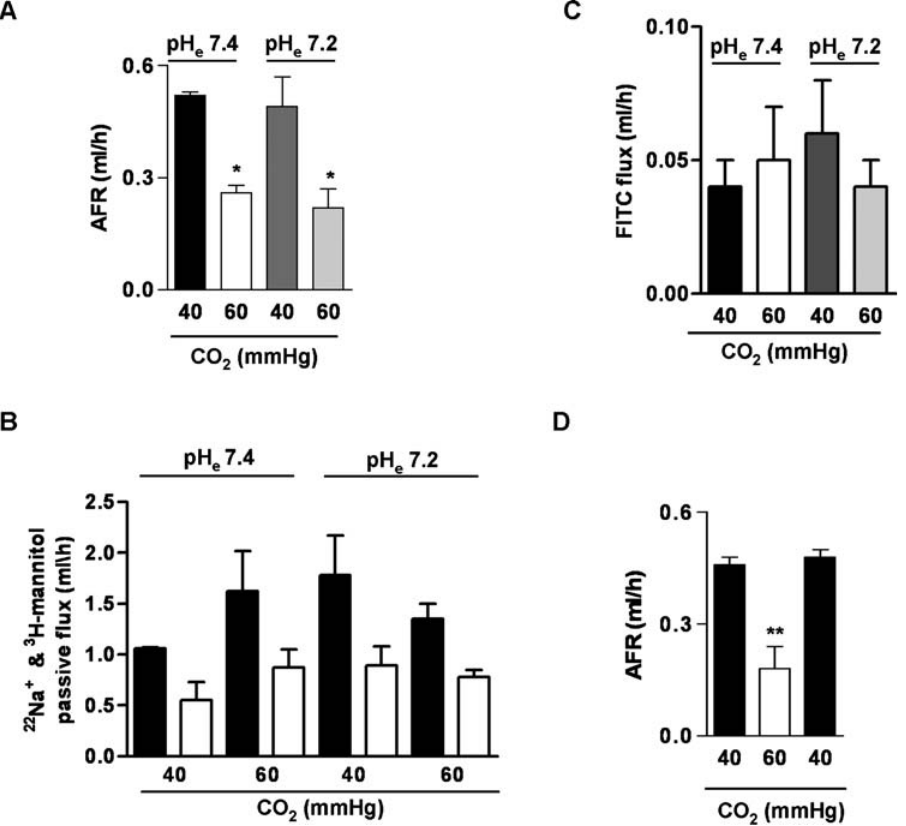
Figure 1.HighCO 2 levelsimpairalveolar epithelialfunction inrats . (A) Isolatedrat lungs wereperfused for 1 hwith40or60 mmHg CO 2 withpH e : 7.4 or pH e : 7.2 and alveolar fluid reabsorbtion (AFR) was measured as described in the experimental procedures. Graph represents the mean 6 SEM, (n=5). (B) Passive movement ofNa + (closed bars) and 3 H-Mannitol (open bars)was measured asdescribedindetail in the supplementarymethods. Graphrepresents the mean 6 SEM(n=5). Differencesamong groupswerenotstatistically significant. (C) Albuminflux fromthe pulmonary circulationintothe alveolarspace was determined from the fraction of fluorescein isothiocyanate (FITC)-labeled albumin, placed in the perfusate that appeared in the alveolar instillate during the experimental protocol. Graph represents the mean 6 SEM, (n=5). Differences among groups were not statistically significant. (D) A three hour experiment was performed in isolated rat lungs. Lungs were perfused for 1h with 40 mmHg CO 2 , switched to 60 mmHg CO 2 for the second hour, and back to 40 mmHg CO 2 for the third hour (pH e : 7.4). Alveolar fluid reabsorption (AFR) was measured as described in the experimental procedures. Graph represents the mean 6 SEM of 5 independent experiments. Bars in panels A, B and C represent the mean from different groups of animals. Bars in panel D represent the mean of single samples from the same group of animals. pH e : extracellular pH. *p , 0.05; **p , 0.01.